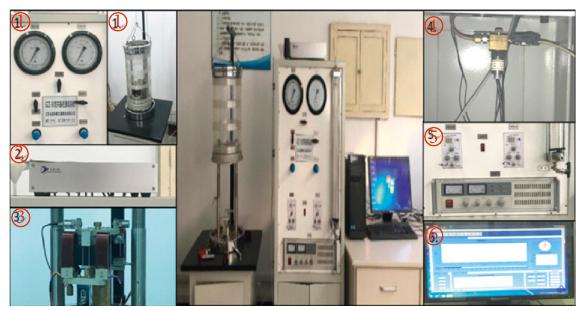
Figure 1: Introduction of free-vibration column of